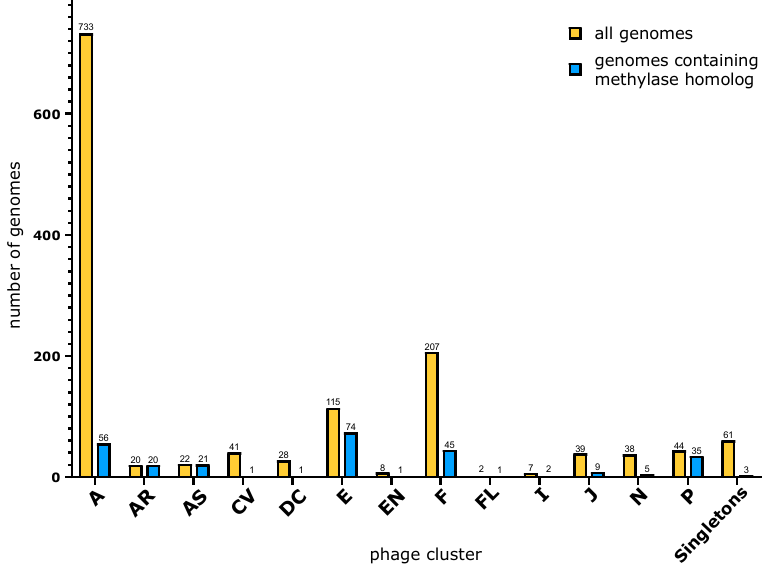
Figure 1. Bar graph depicting the total number of genomes per phage cluster in PhagesDB as of 27 December 2022 ( yellow ) and the number of genomes encoding a methylase in our dataset ( blue ). The clustering of phages in PhagesDB reflects overall nucleotide similarity, gene order, and gene content [26]. See the Methods Section for details.